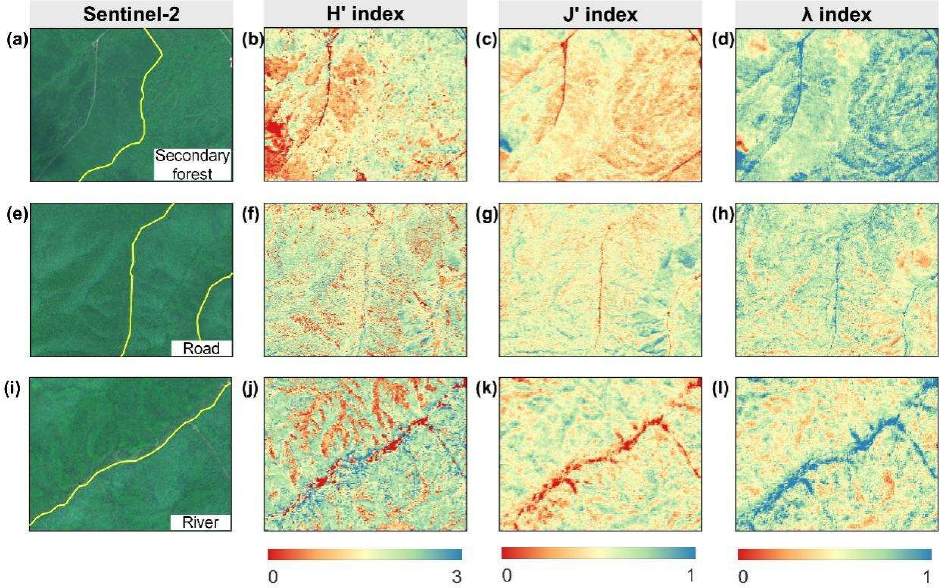
Figure 5. Zoom-in examples of true color Sentinel-2 images (RGB = bands 4, 3, 2) and forest diversity predictions under different forest environments. Sentinel-2 image ( a ) contains two forest types, secondary forest (right) and natural forest (lift); Images ( e , i ) show natural forests traversed by rivers and roads. The ( b – d ), ( f – h ), and ( j – l ) indicate three diversity index results corresponding to images ( a , e , i ).